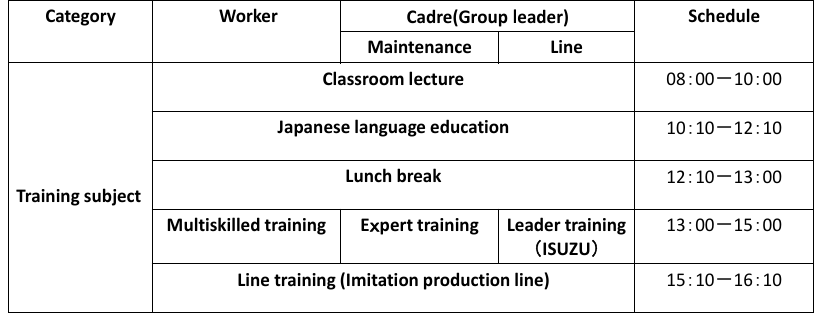
Source: According to the interview data of WuxiTongzhong (2019).